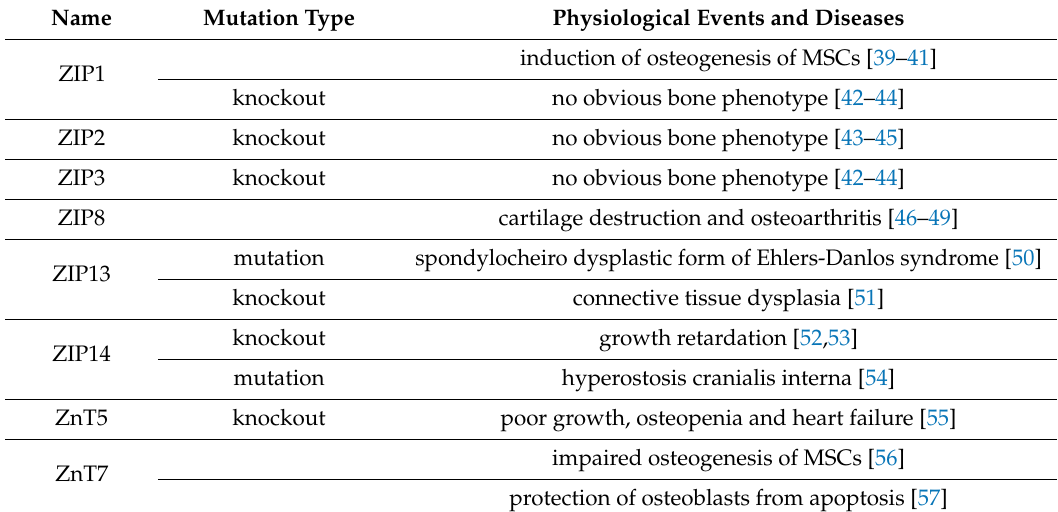
Table 1. Zrt- and Irt-like protein (ZIP) and zinc transporter (ZnT) proteins in bone physiology and